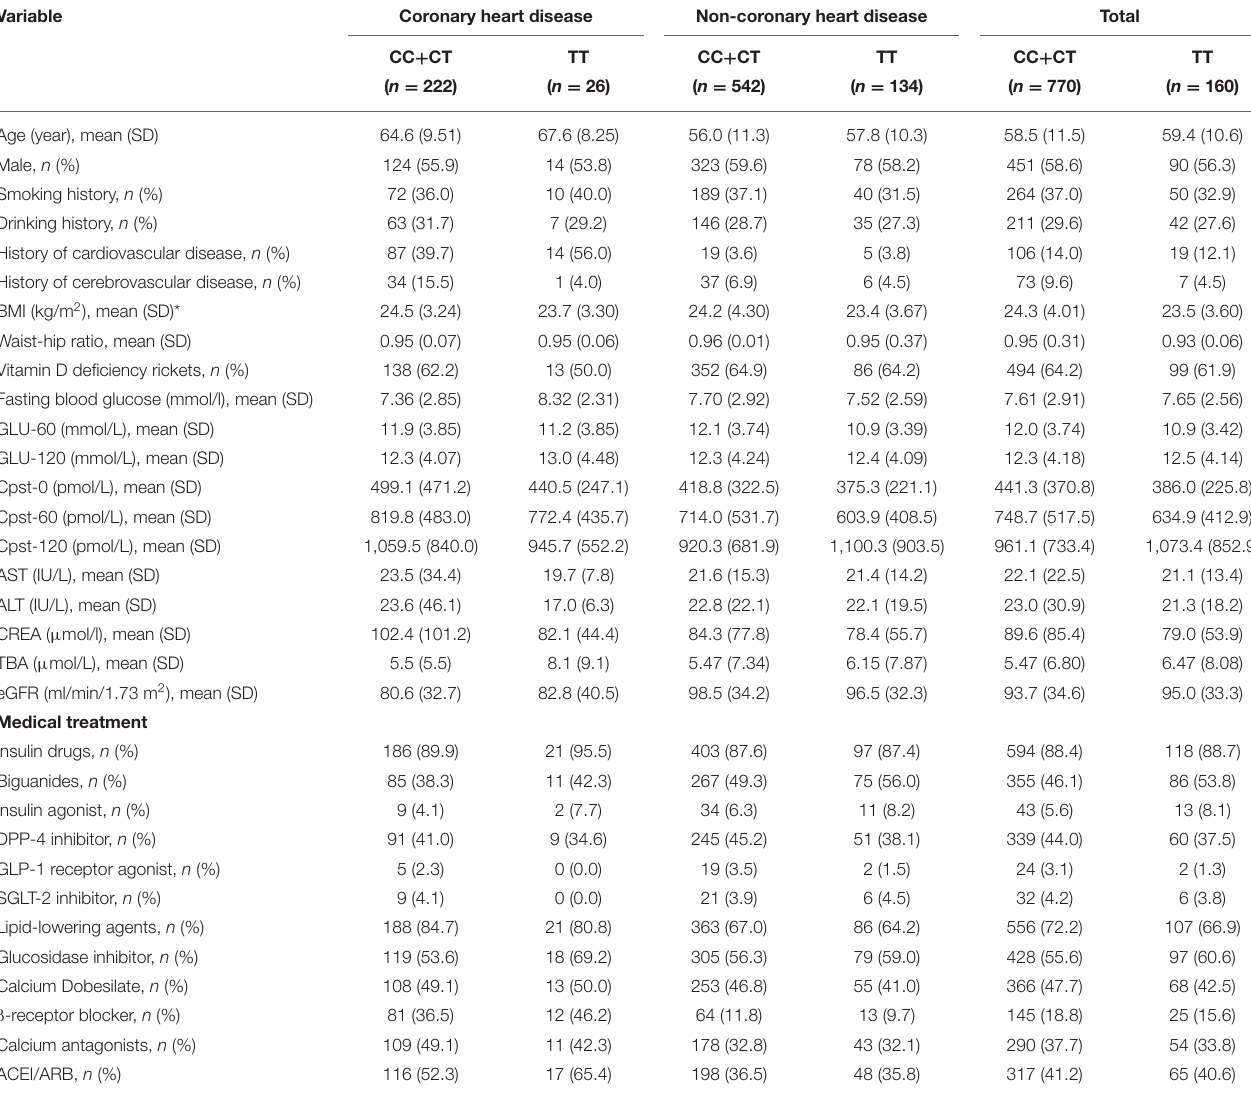
TABLE 1 | Baseline characteristics of T2DM patients with rs1800504.